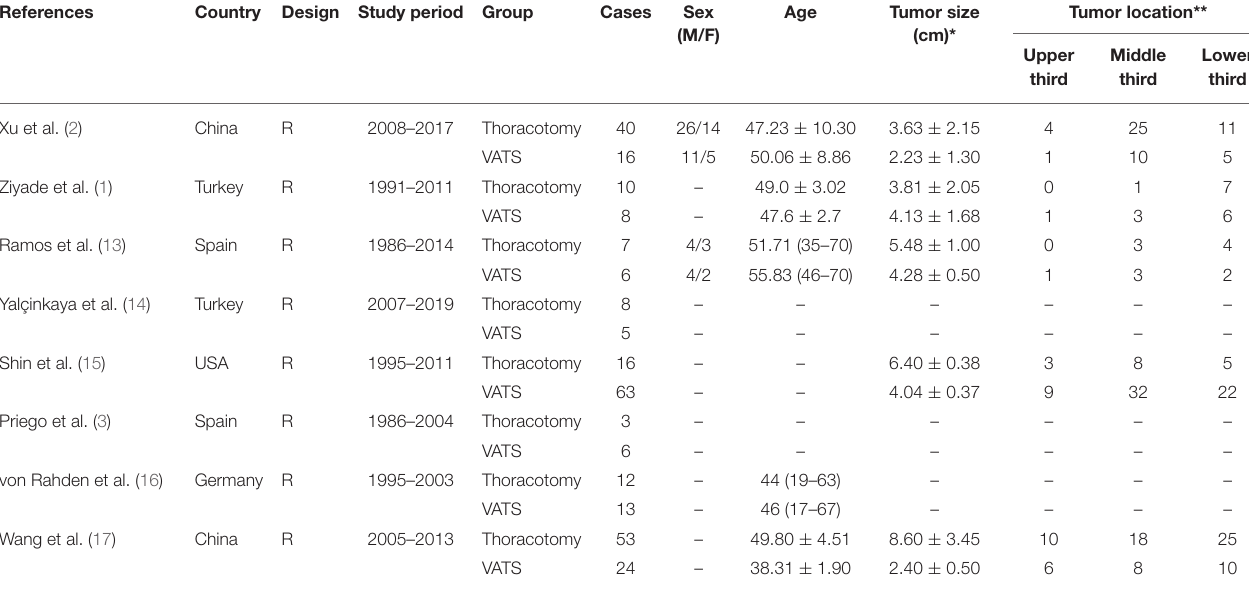
TABLE 2 | Characteristics of the included